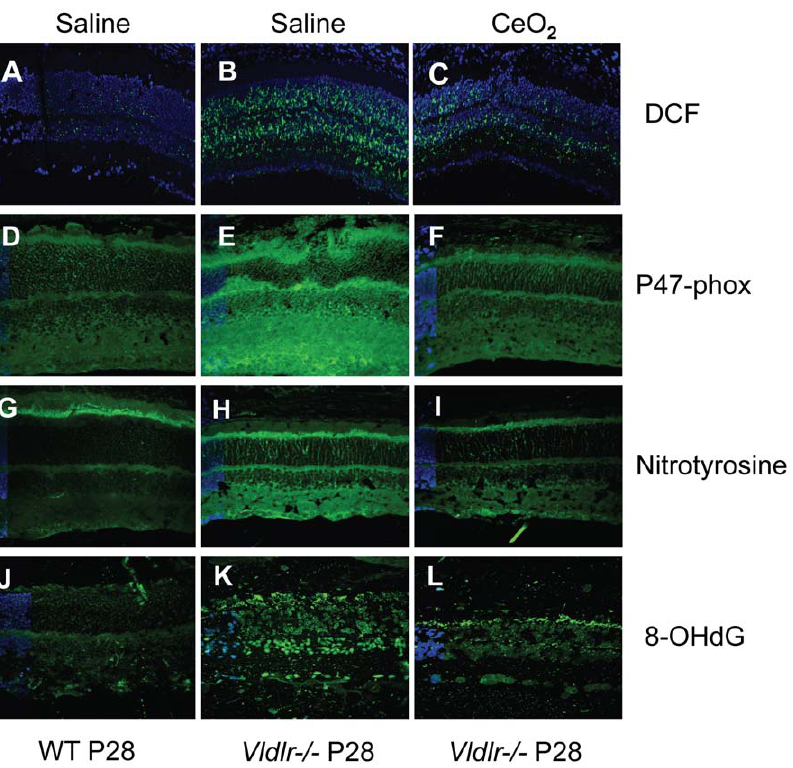
Figure 2. Nanoceria reduce oxidative stress in the Vldlr-/- retina. Retinal sections from saline injected WT mice ( A,D,G,J ); saline injected Vldlr-/- mice ( B,E,H,K ) and CeO 2 injected ( C,F,I,L ) Vldlr-/- mice are shown as imaged by confocal microscopy. The DCF assay ( A,B,C ) visualizes ROS as punctuate fluorescence and demonstrates a very low level of ROS in the normal ( A ), a considerable amount in the Vldlr-/- ( B ), and a greatly reduced amount in the retina of the Vldlr-/- mice injected with CeO 2 ( C ). Similar results were obtained with the other three assays. NADPH-oxidase, (P47-phox; D,E,F ) a major producer of ROS, was very high in the Vldlr-/- retina and almost reduced to control levels in the CeO 2 injected mice. Nitrotyrosine, ( G,H,I ) a reflection of oxidative activity due to increases in nitric oxide concentration, was highest in the Vldlr-/- retina and significantly reduced in the nanoceria injected mice. ROS-mediated damage to DNA was indicated by the labeling of the retina with an antibody against a DNA adduct, 8-hydroxy-2 9 -deoxyguanosine (8-OHdG; J,K,L ) which showed little labeling in the control, significant labeling in the saline injected Vldlr-/- retina, and a greatly reduced amount in the nanoceria treated retina. DAPI (blue) was used to visualize the nuclei.